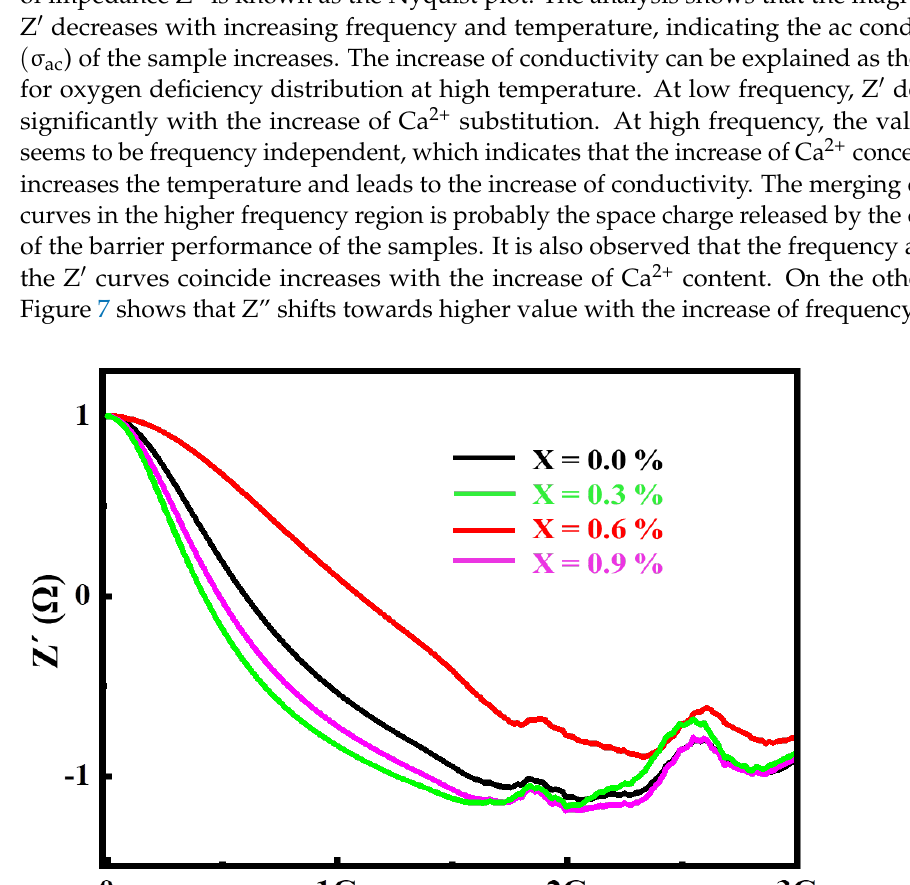
Figure 7. Frequency-dependent variation of imaginary parts of impedance for (Ba 1−x Ca x )Ti 4 O 9 (x = 0.0, 0.3, 0.6 and 0.9) sintered ceramics at 1000 °C for 4 h.